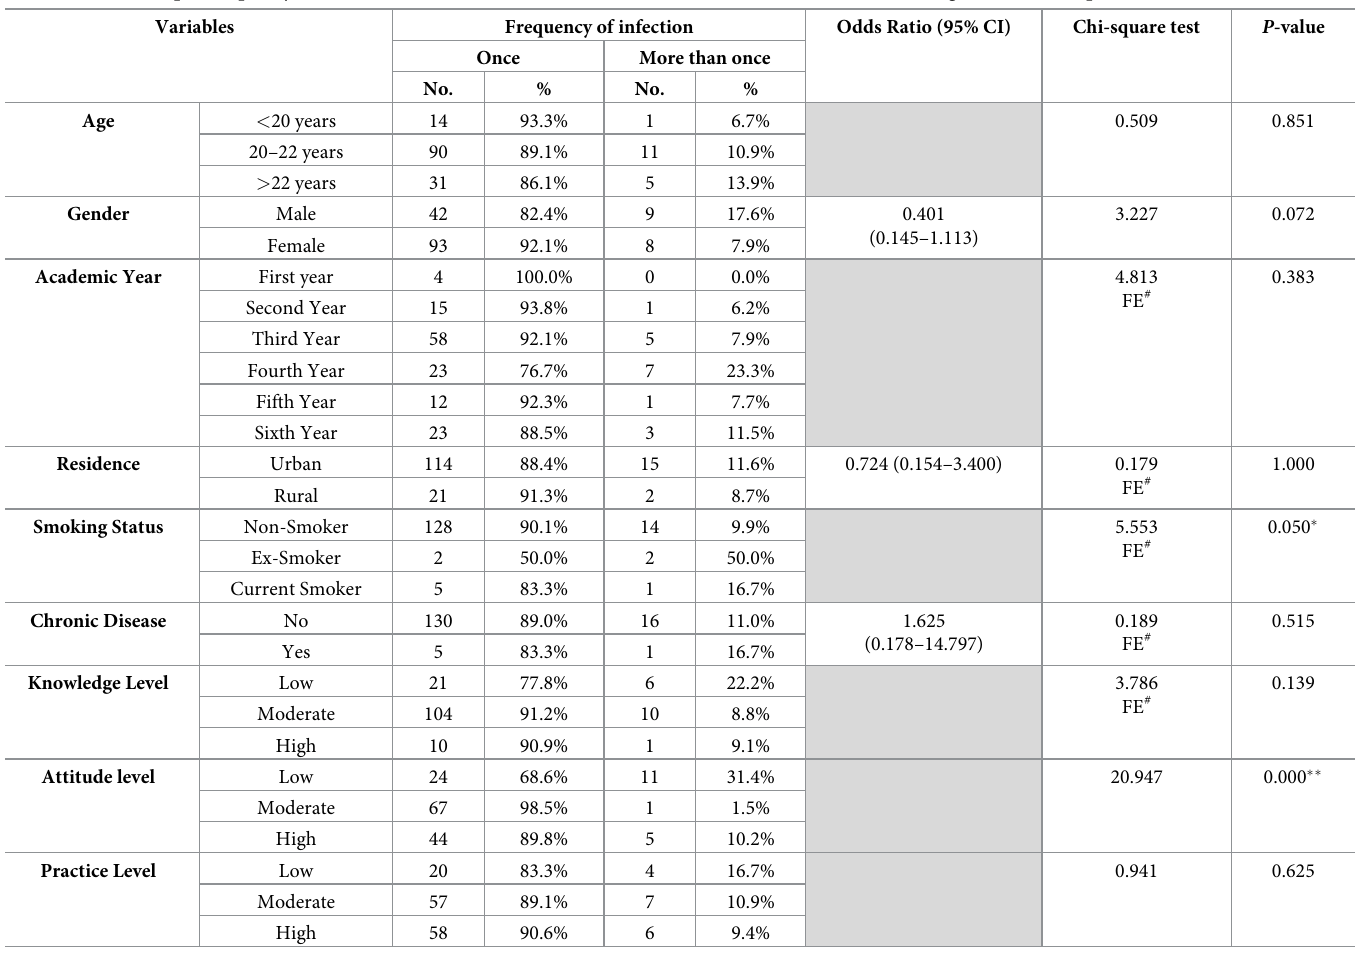
Table 3. Relationship of frequency of infection of medical students with their characteristics and levels of knowledge, attitude, and practice (n = 151).